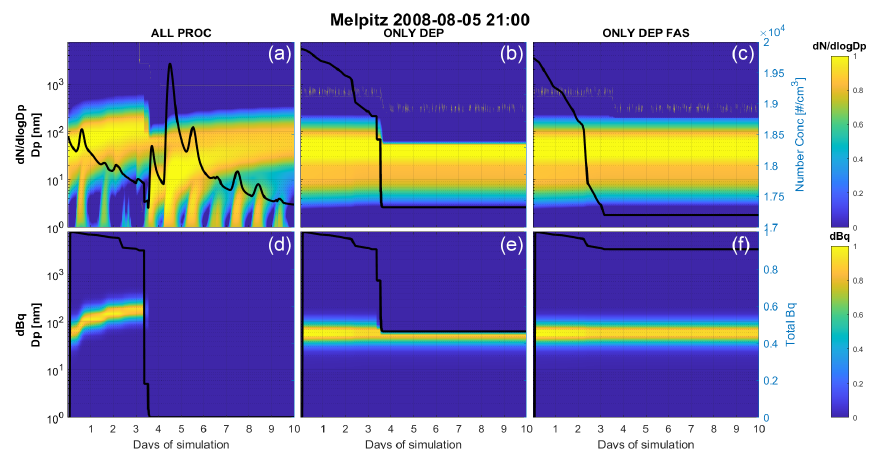
Figure 10. Result from one trajectory: Melpitz on 5 August 2008 at 21:00. Evolution of size distribution spectra for number concentration (d N/ dlog D p , normalized, a–c ) and caesium concentration (dBq, normalized, d–f ). Three different experiments: ALL PROC (a, d) , ONLY DEP (b, e) and ONLY DEP FAS (c, f) . The black lines represent total number concentration and total Becquerel concentration, respectively (axes to the right). Please note that the date in this figure is given in the format of year month day